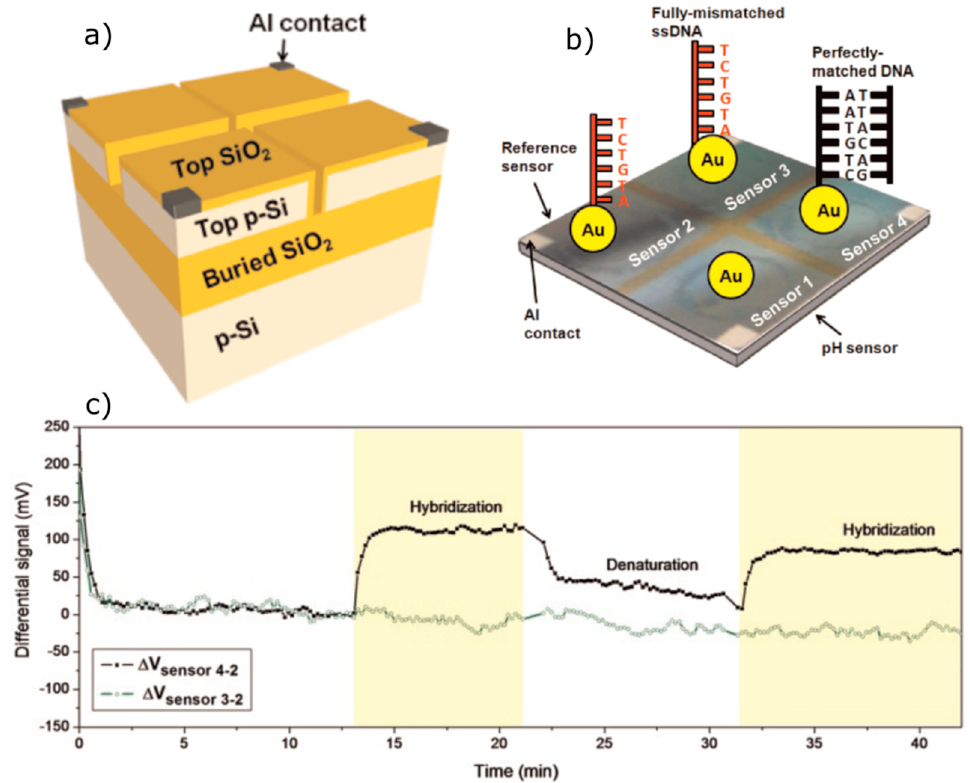
Figure 8. Schematic of the bare ( a ) and AuNP-modified (5–8 nm) ( b ) EIS chips combining four individually addressable EIS sensors prepared using a silicon-on-insulator wafer and a differential-mode ConCap response after consecutive DNA hybridization, denaturation, and rehybridization ( c ). Δ V 4-2 and Δ V 3-2 : net differential signals between sensor 4 and sensor 2 and sensor 3 and sensor 2, respectively. Adapted from Ref. [135] with permission from Wiley-VCH.